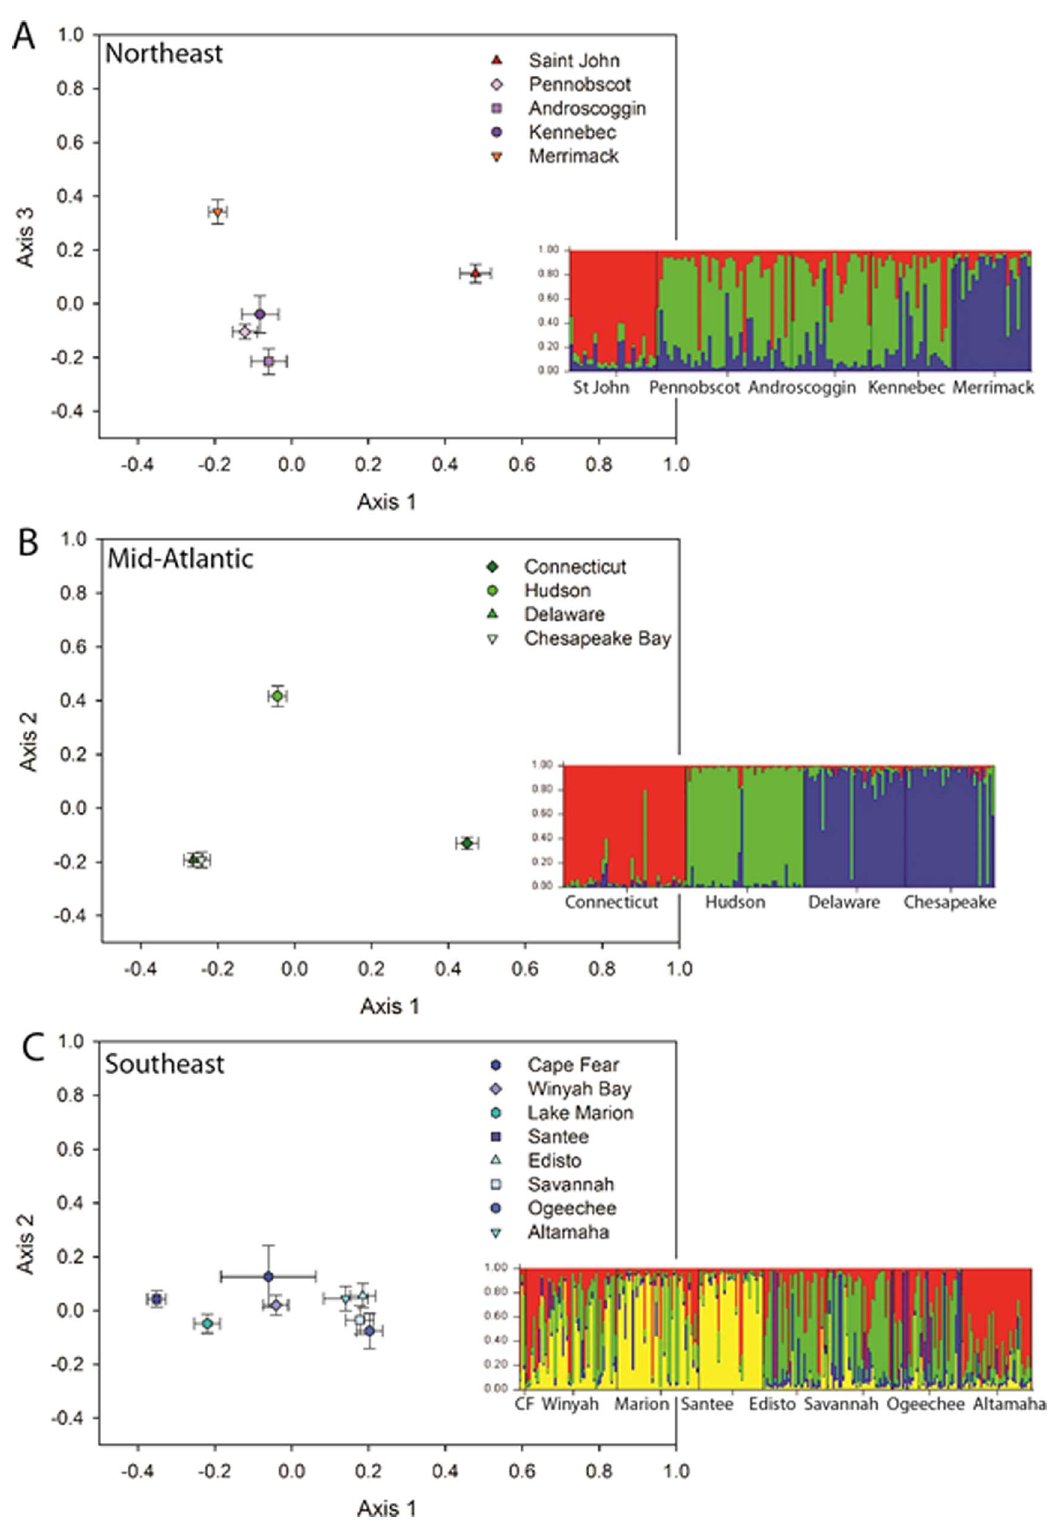
Figure 3. Combined graphical representation of sequential principal coordinates (scatter plots) and STRUCTURE (histograms) analyses of 561 shortnose sturgeon ( Acipenserbrevirostrum ) surveyed at 11 polysomic microsatellite DNA loci. For the STRUCTURE histograms, each individual is represented by a single vertical bar, broken into k colored segments, the length of which is proportional to the membership fraction in each of the k clusters. Black lines partition the river samples. A) Northeast region collections; B) Mid-Atlantic region collections; C) Southeast region collections.